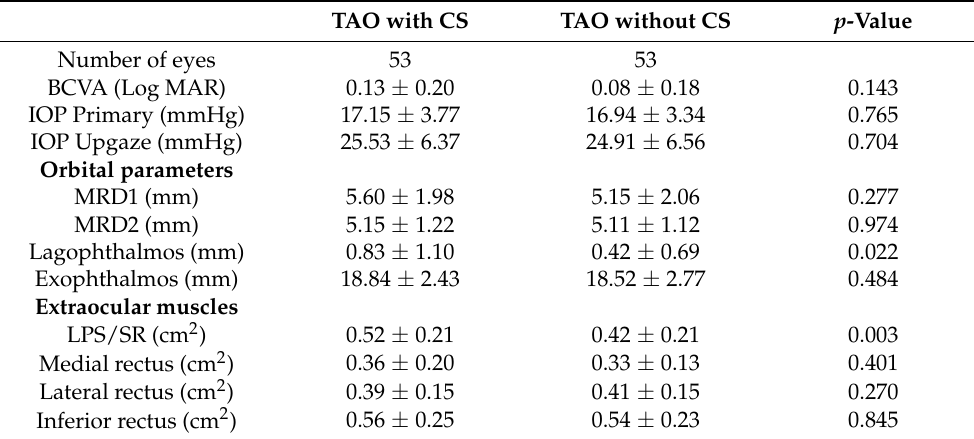
Table 2. Comparison of measurement results between TAO eyes with and without corneal striae in 53 TAO